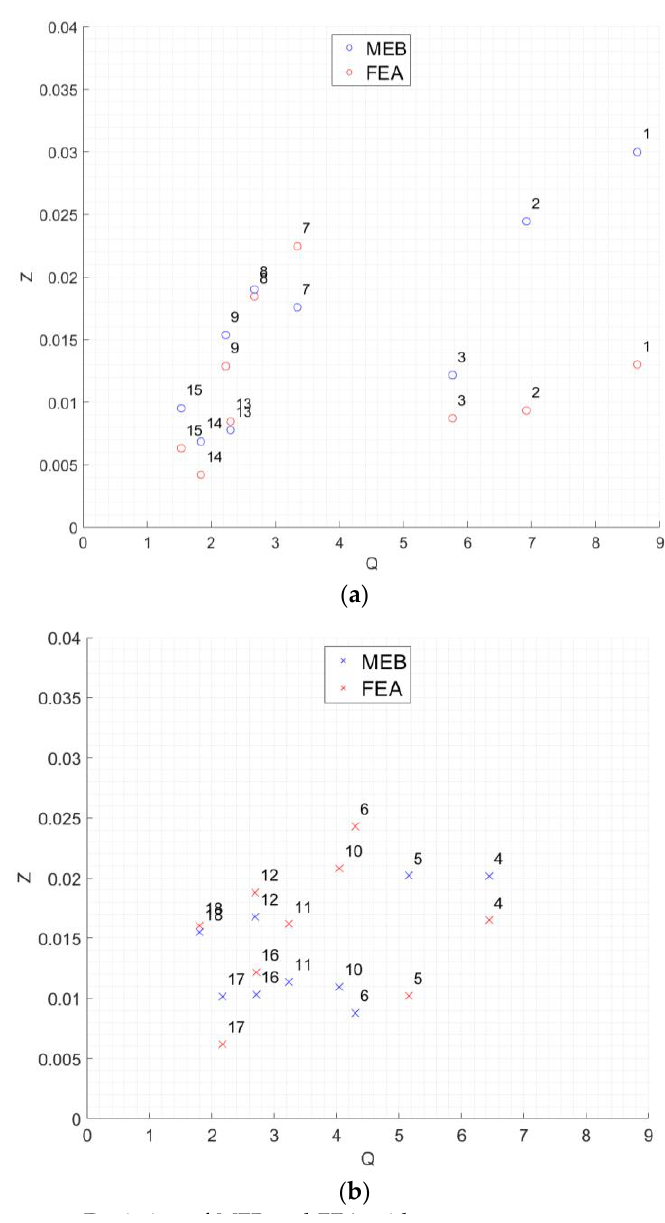
Figure 8. Deviation of MEB and FEA with respect to average experimental results; ( a ) specimens with 𝑙 = 10 mm ; ( b ) specimens with 𝑙 = 15 mm .